Question: Provide a one-line summary of what is displayed.
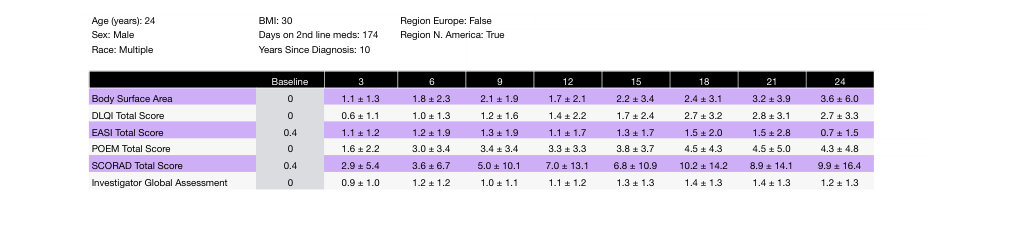
Answer: An example twin record for a single ATD patient is shown, which reports the mean and standard deviation of the twins for that patient. A sample of static baseline information is given at the top of the record. A sample of longitudinal outcomes predicted by the model are supplied as rows, with columns indicating the time in months since baseline visit.